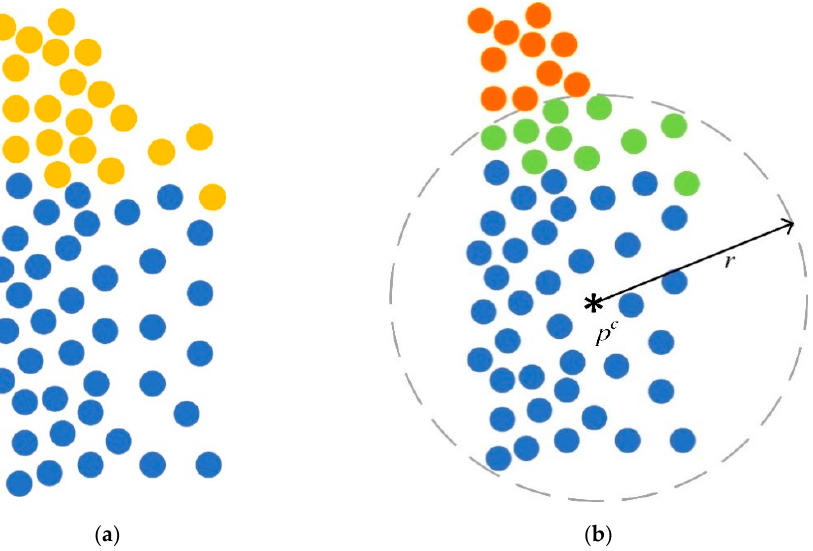
Figure 2. Neighbors growing based on joint K -neighbors and fixed radius. ( a ) Neighbors growing based on K -neighbors; ( b ) neighbors growing under the constraint of the fixed radius. In ( a ), blue points are the starting points, while orange points are the growing points using K nearest neighbors. In ( b ), green points are the final growing points for the blue points under the constraint of a fixed radius. Red points are the excluded points.